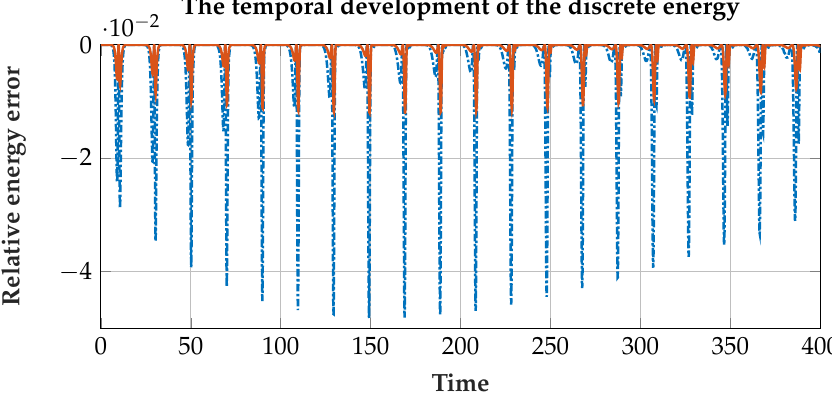
Figure 6. Evolution of the relative energy error for the non-linear seismic wave